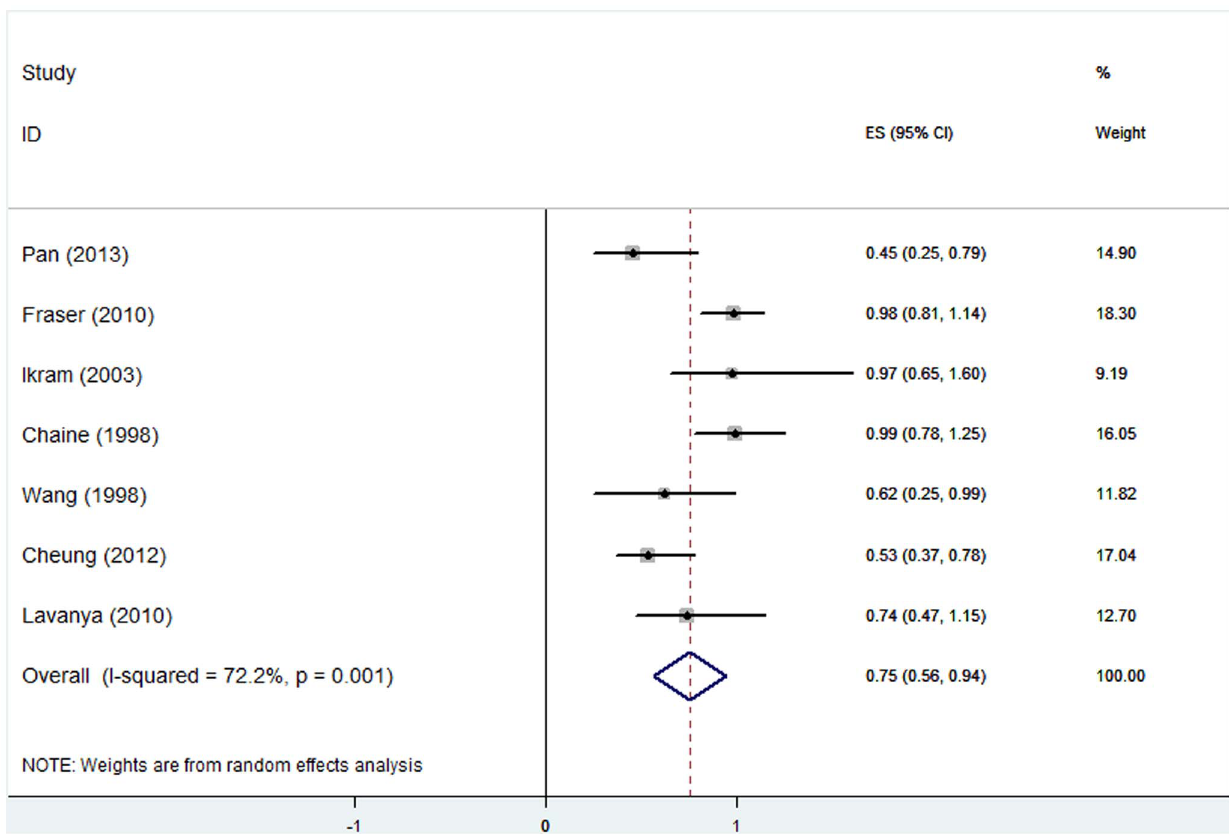
Figure 4. Myopia and early AMD prevalence: forest plot of pooled odds ratios for a random-effects meta-analysis of early AMD prevalence and myopia. CI, confidence interval.